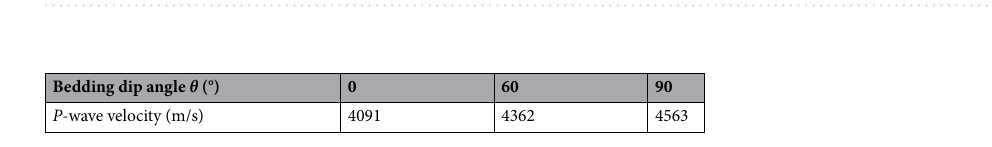
Table 1. Mean acoustical properties for shale specimens with three types of bedding dip angles.